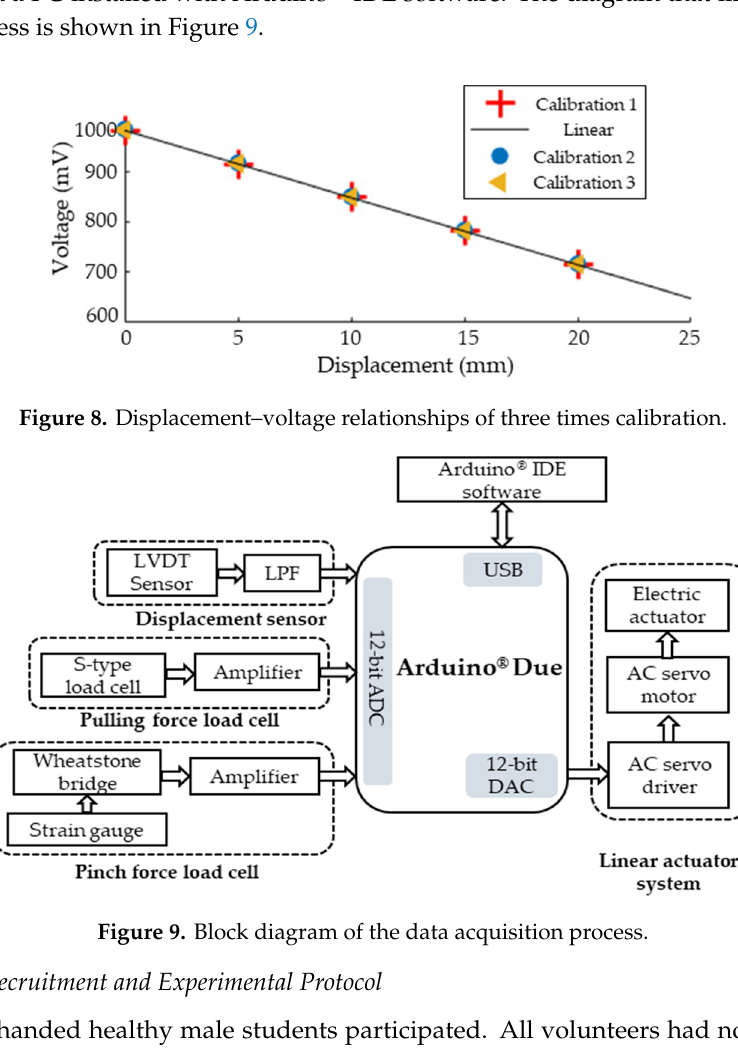
Figure 9. Block diagram of the data acquisition process.